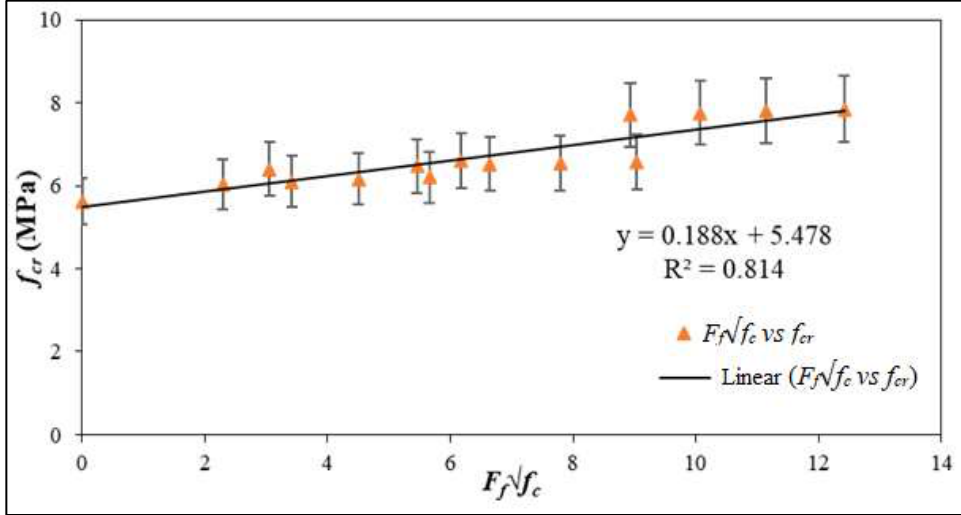
Figure 7. Comparison of modulus of rupture.